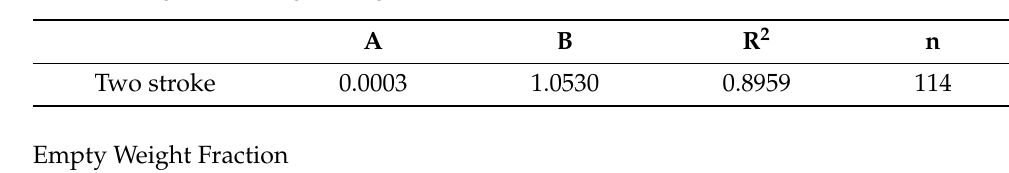
Table 3. Weight of ICE engines, regression